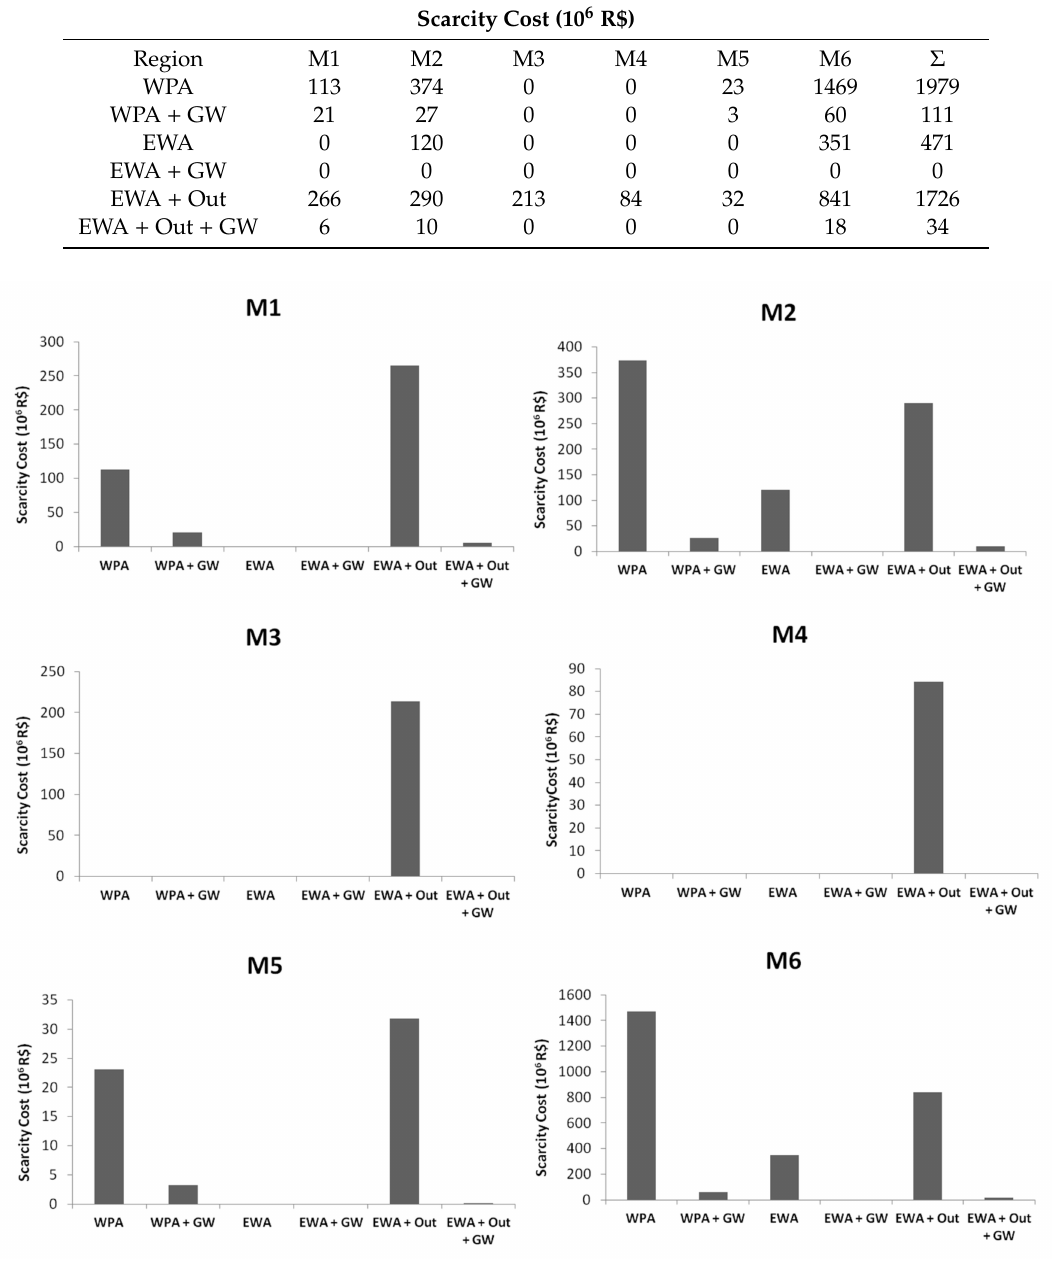
Figure 6. Scarcity cost (10 6 R$) comparison of all scenarios simulated in each